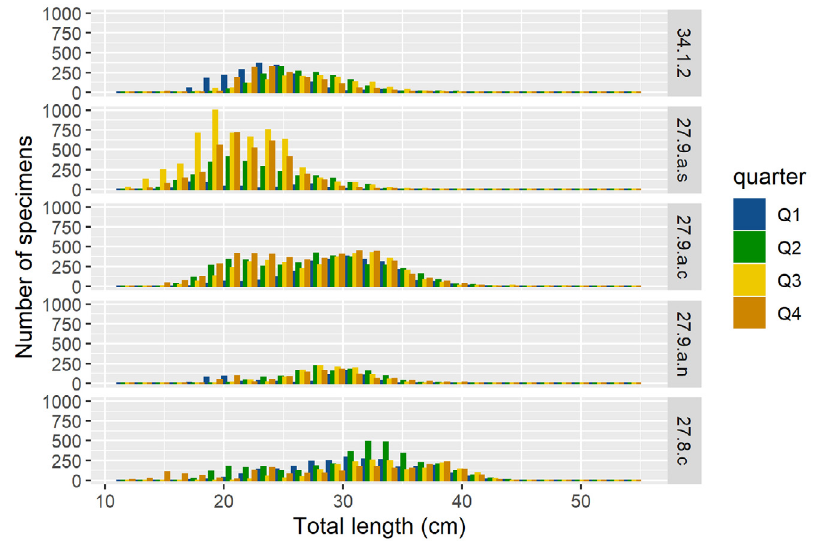
Fig. S1. – Total length distribution of sampled fish per quarter in each study area. Geographical study areas from south to north are 34.1.2, Canary Islands; 27.9.a.s, Gulf of Cadiz; 27.9.a.c, W Portuguese coast; 27.9.a.n, NW Spanish coast; 27.8.c., Cantabrian Sea.